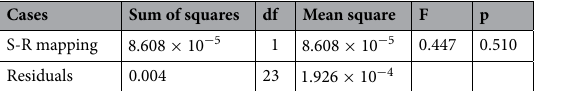
Table 3. Between subjects effects on accuracy.